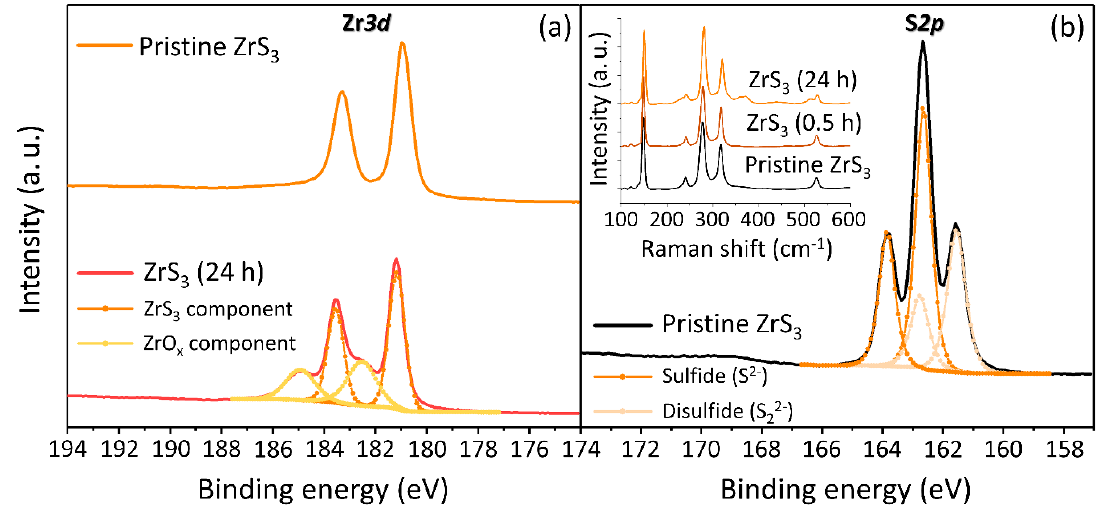
Figure 3. Spectroscopic characterization of ZrS 3 crystals before and after sonication. ( a ) Comparison of XPS Zr 3d spectra of pristine ZrS 3 crystals (top) and ZrS 3 nanoparticles stored in water for 24 h (bottom); ( b ) XPS S 2p spectrum of pristine ZrS 3 . Inset shows Raman spectra of pristine ZrS 3 crystals,